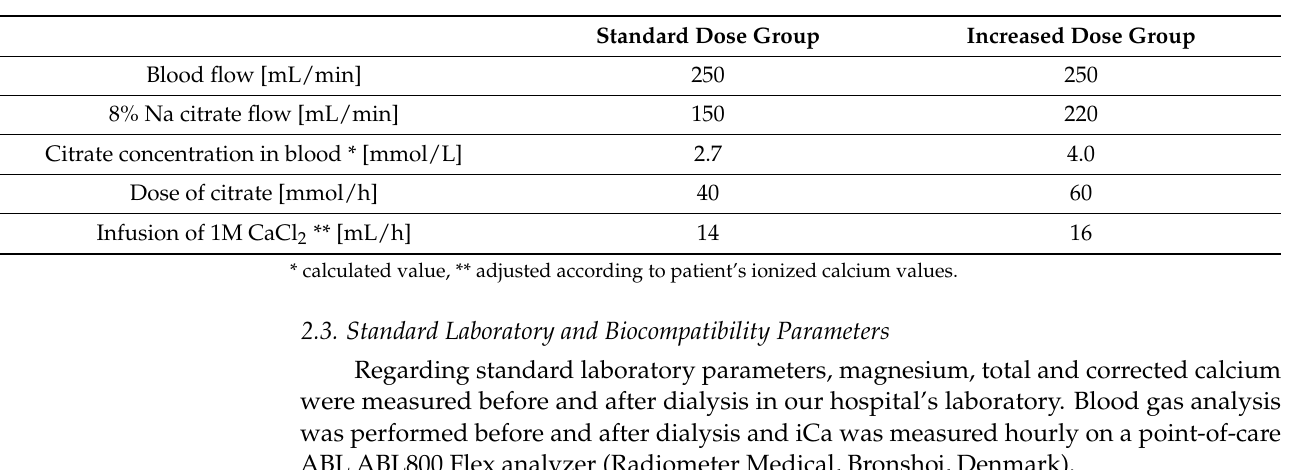
Table 1. Initial regional citrate anticoagulation parameters in both